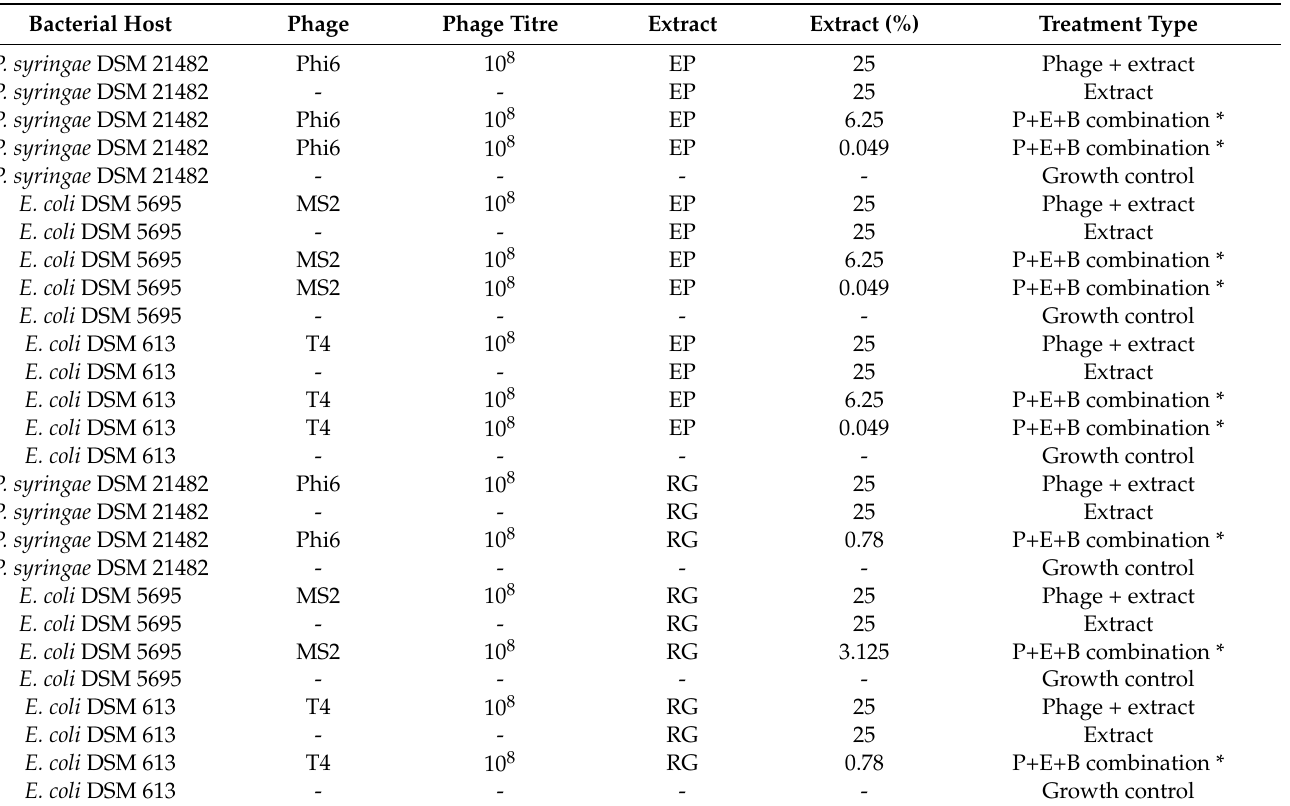
Table 2. Chosen treatment combinations for real-time assessment of bacterial growth. EP: Echinacea purpurea extract; RG: Ruta graveolens